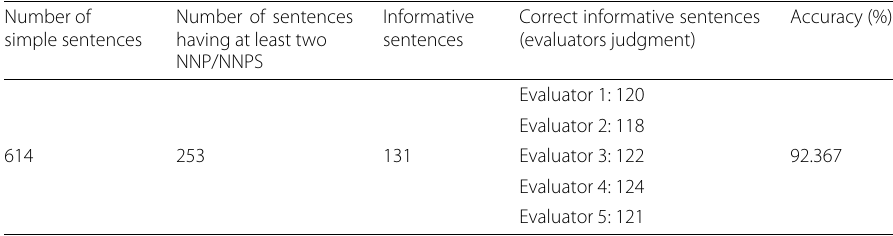
Table 3 Accuracy of informative sentence generation Number of Number of sentences simple sentences having at least